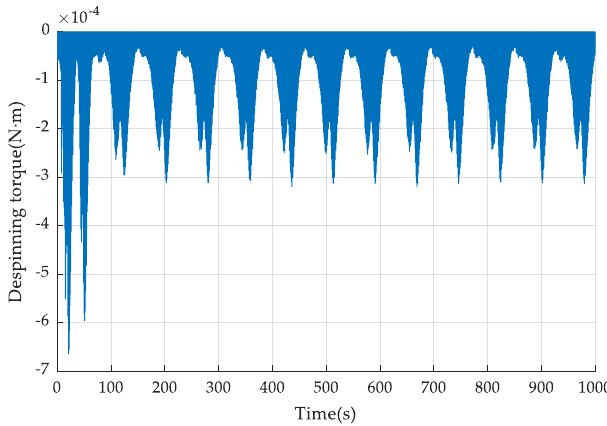
Figure 17. Enhanced eddy current torque curve.